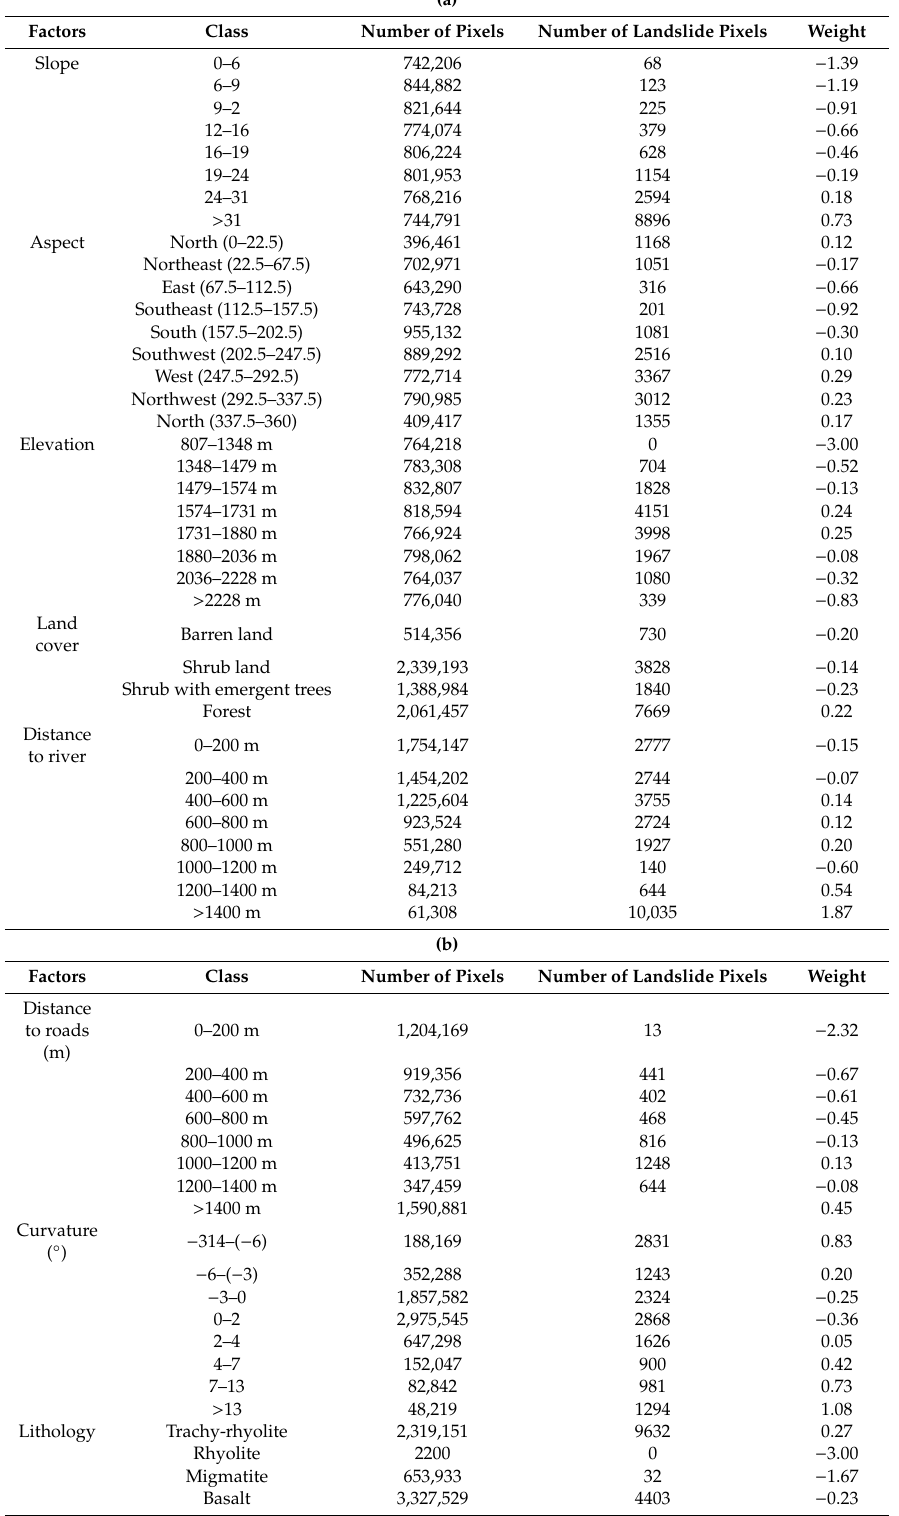
Table 7. ( a ) Computed weights of geo-environmental factors classes using the information value method: slope ( ◦ ), aspect ( ◦ ), elevation (m), land cover, distance to river (m); ( b ) Computed weights of geo-environmental factors classes using the information value method: distance to roads (m), curvature ( ◦ ), and